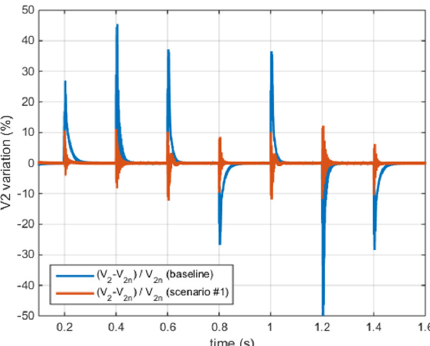
Figure 5. Grid voltage variation in the baseline scenario and Scenario #1 (SS − GN).